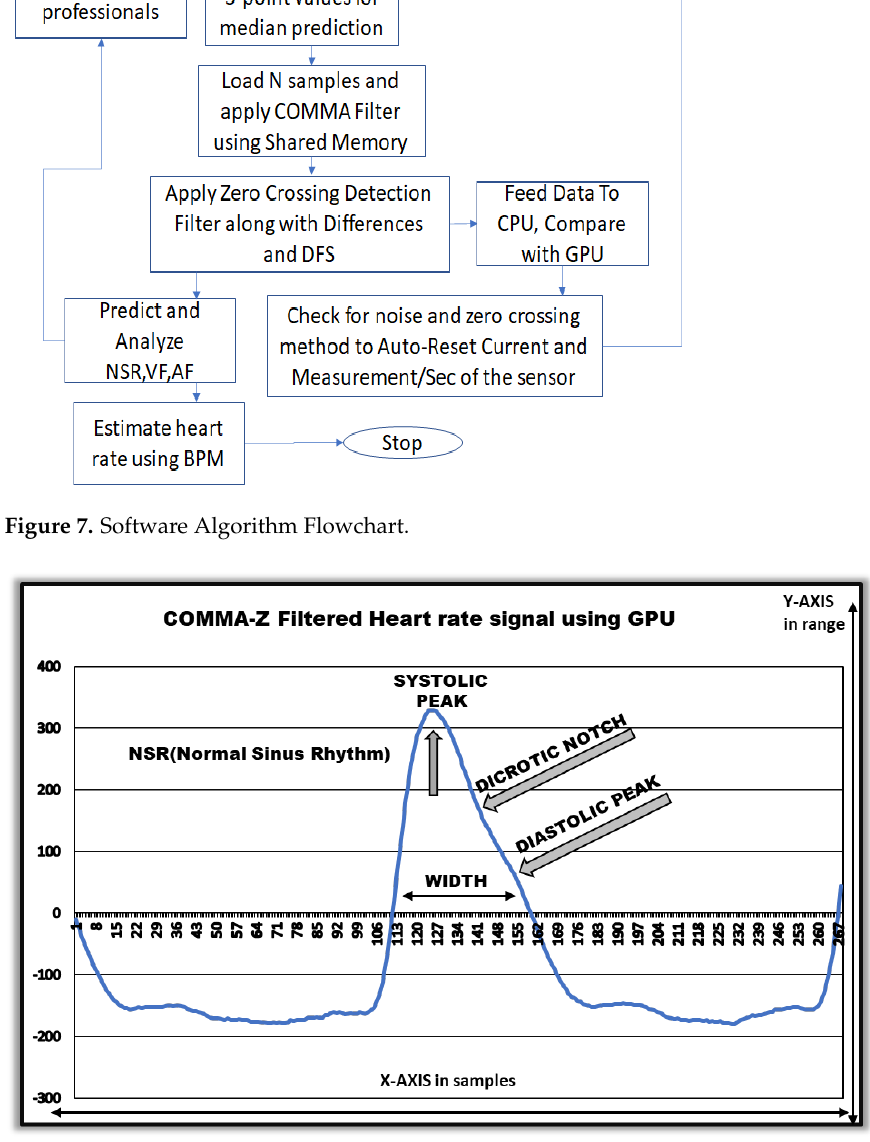
Figure 8. GPU-Filtered Normal Sinus Rhythm.